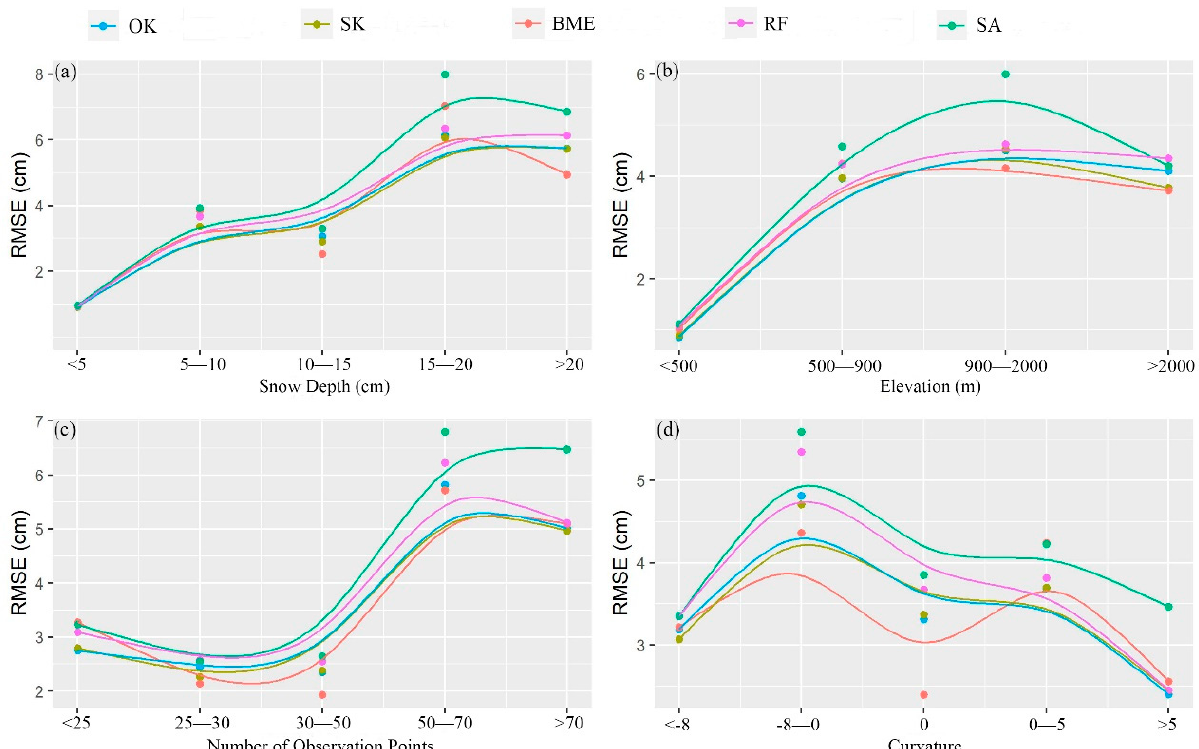
Figure 4. ( a – d ) Upscaling results of 25 km 2 snow plots in different scenarios.